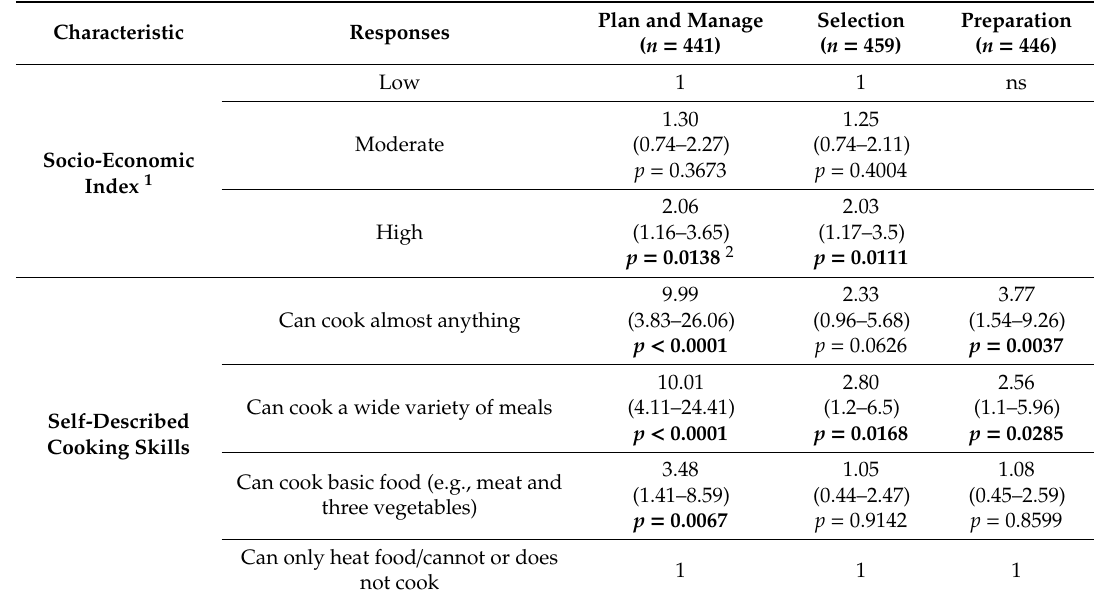
Table 5. Demographic and dietary behaviours associated with maintained or increased food literacy behaviour between end-of-program and follow-up questionnaires (those scoring high at the program’s end and on follow-up, or scoring moderate at the program’s end and scoring moderate or high on follow-up). ns: not statistically